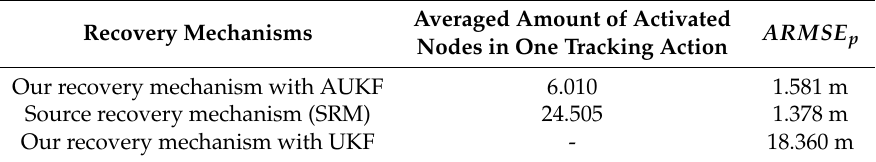
Table 3. Features of different recovery mechanisms.